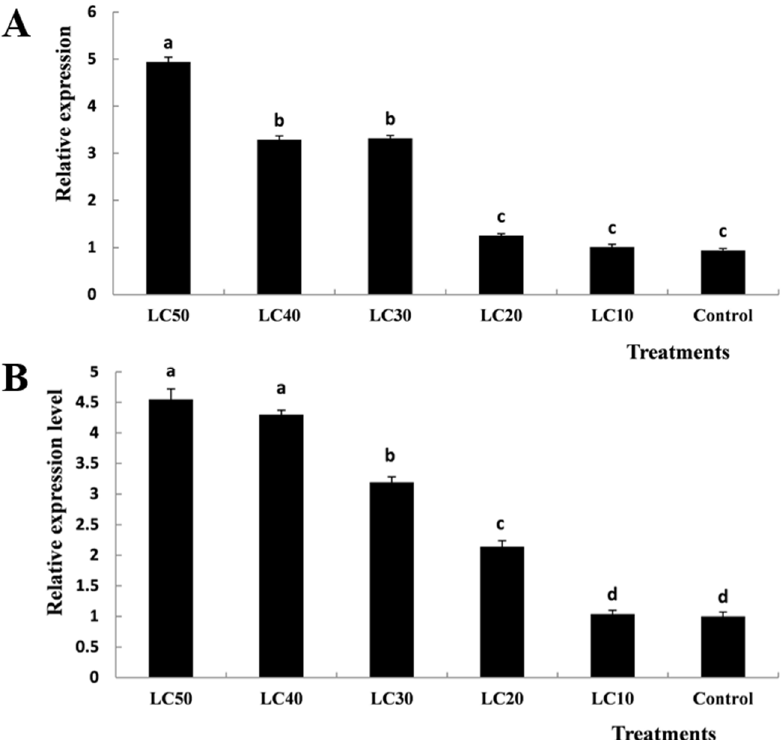
Figure 5. Effects of different concentrations of diflubenzuron on the mRNA relative expression levels in T. cinnabarinus eggs ( A ) and larvae ( B ). Bar graphs represent means ± SE; different lowercase letters on each bar indicate significant differences ( p < 0.05).